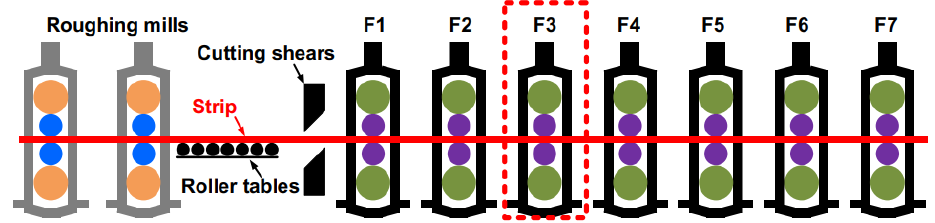
Figure 1. Diagram of equipment composition for hot rolling mill.